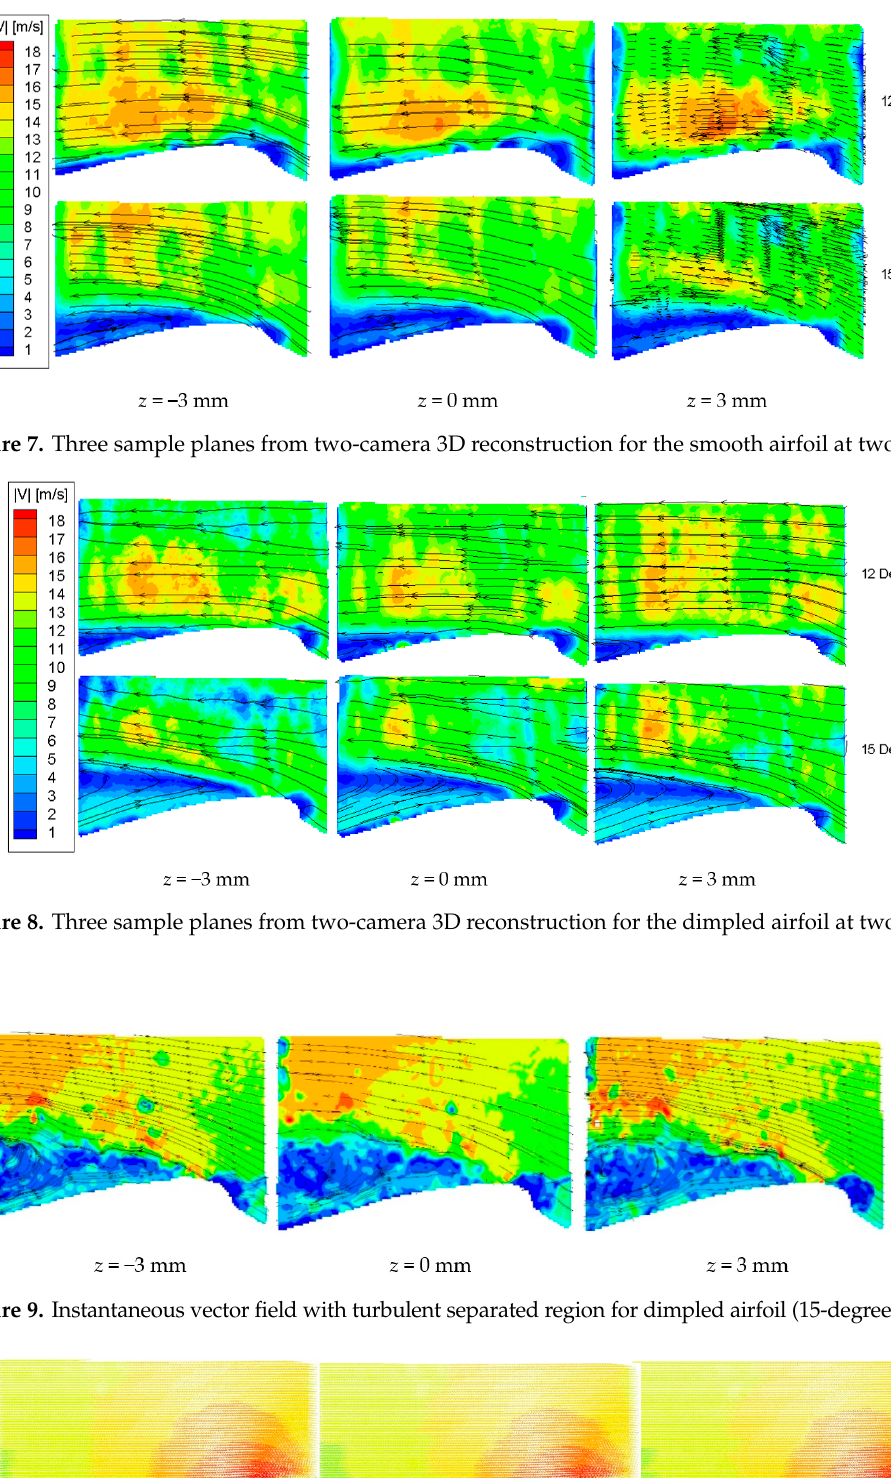
Figure 7. Three sample planes from two-camera 3D reconstruction for the smooth airfoil at two AoA.